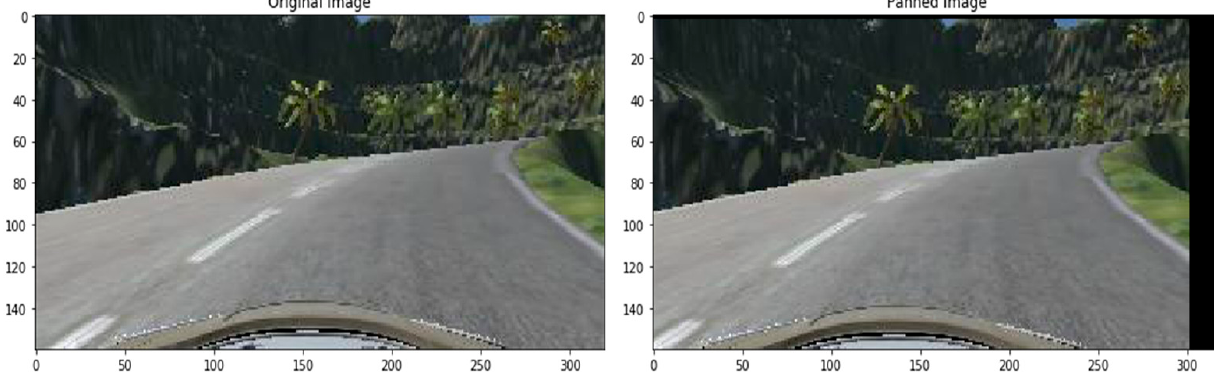
Figure 12. Panned image.